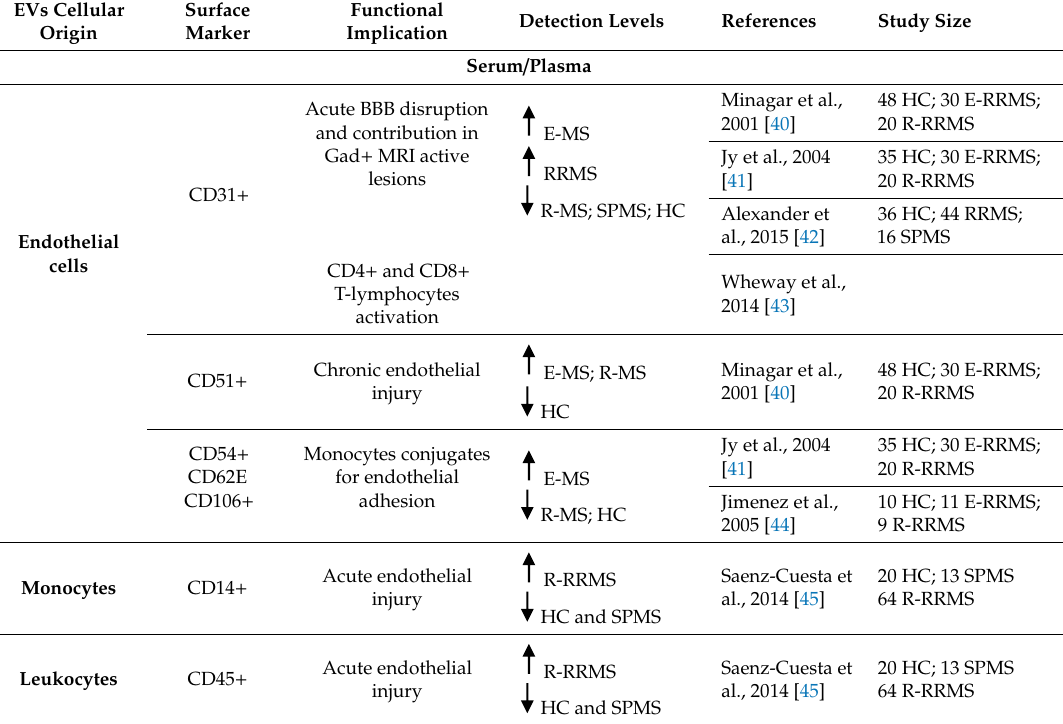
Table 1. Extracellular vesicle (EV) classification and their potential role in multiple sclerosis (MS). EVs Cellular Origin